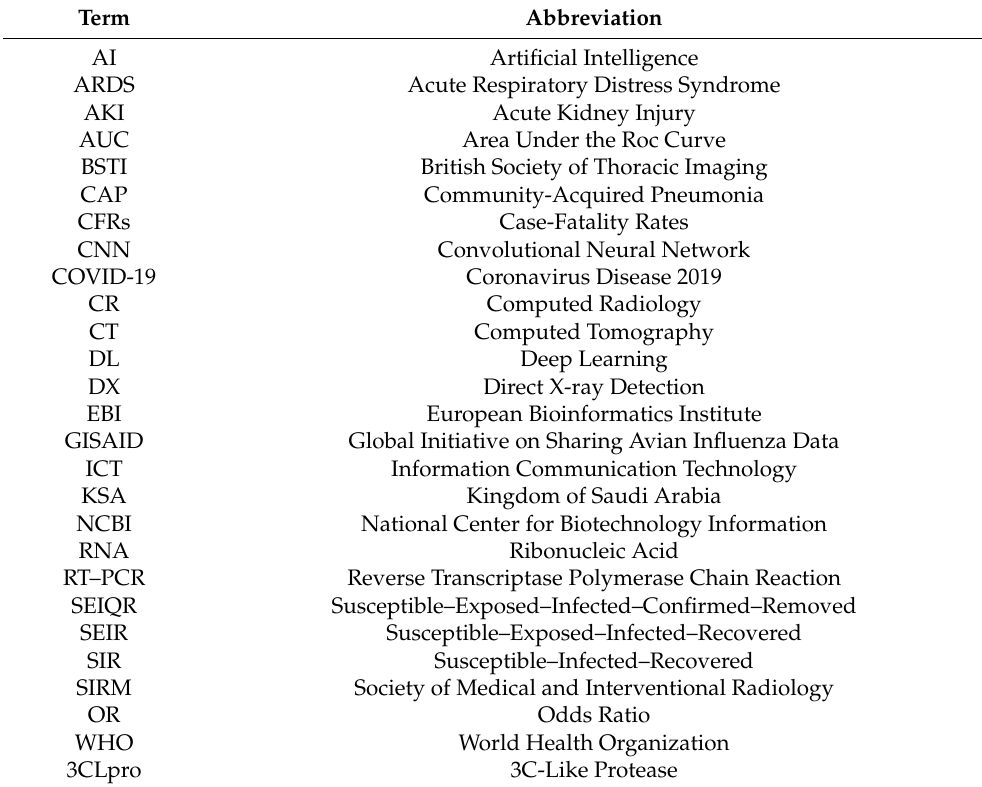
Table 1. List of